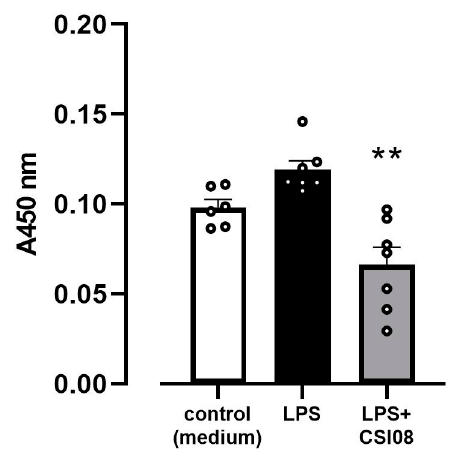
Figure 8. B. clausii CSI08 down-regulated the LPS-stimulated activation of NF- κ B in HT-29 cell line. Adsorption values correspond to the levels of the transcription factor in the nuclear fractions of control cells, cells exposed to 15 ng/mL of LPS for 45 min, cells pretreated with B. clausii CSI08 for 20 h prior to adding LPS. Values are means ± SEM of two independent experiments. ** p < 0.01 vs. LPS.